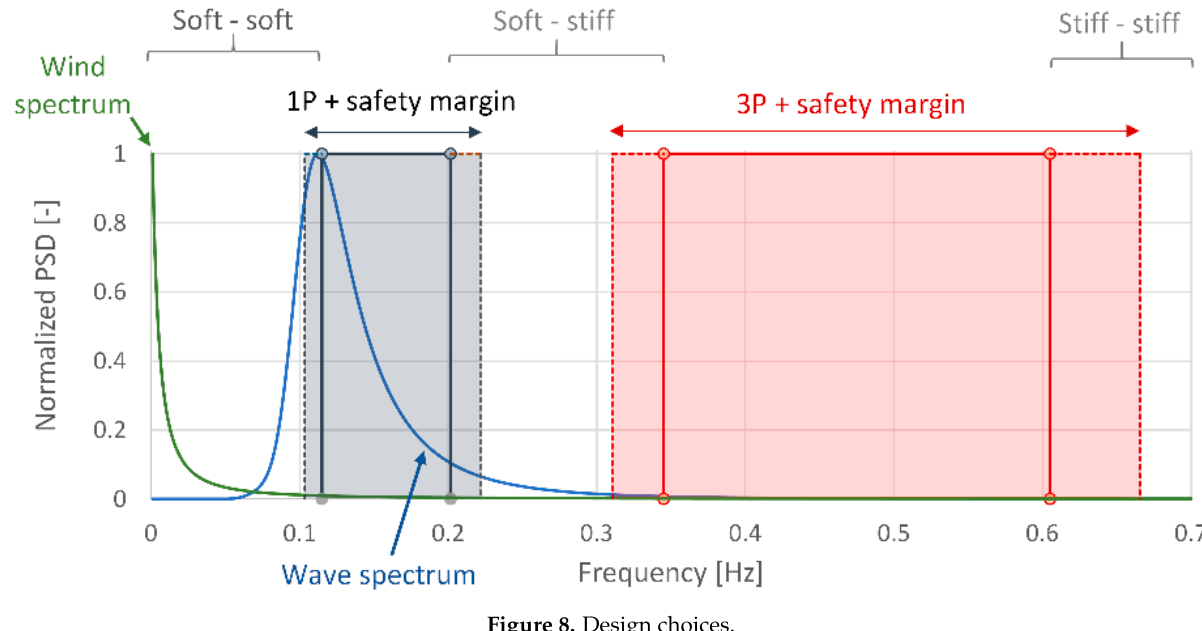
Figure 8. Design choices.